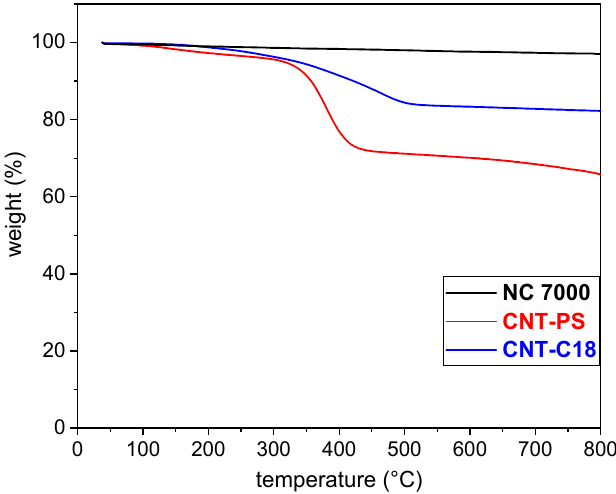
Figure 1. Thermogravimetric analysis (TGA)-curves of MWCNTs NC 7000, CNT-C18, and CNT-PS.